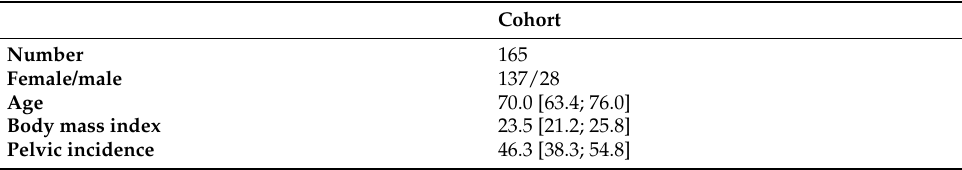
Table 1. Demographics of the